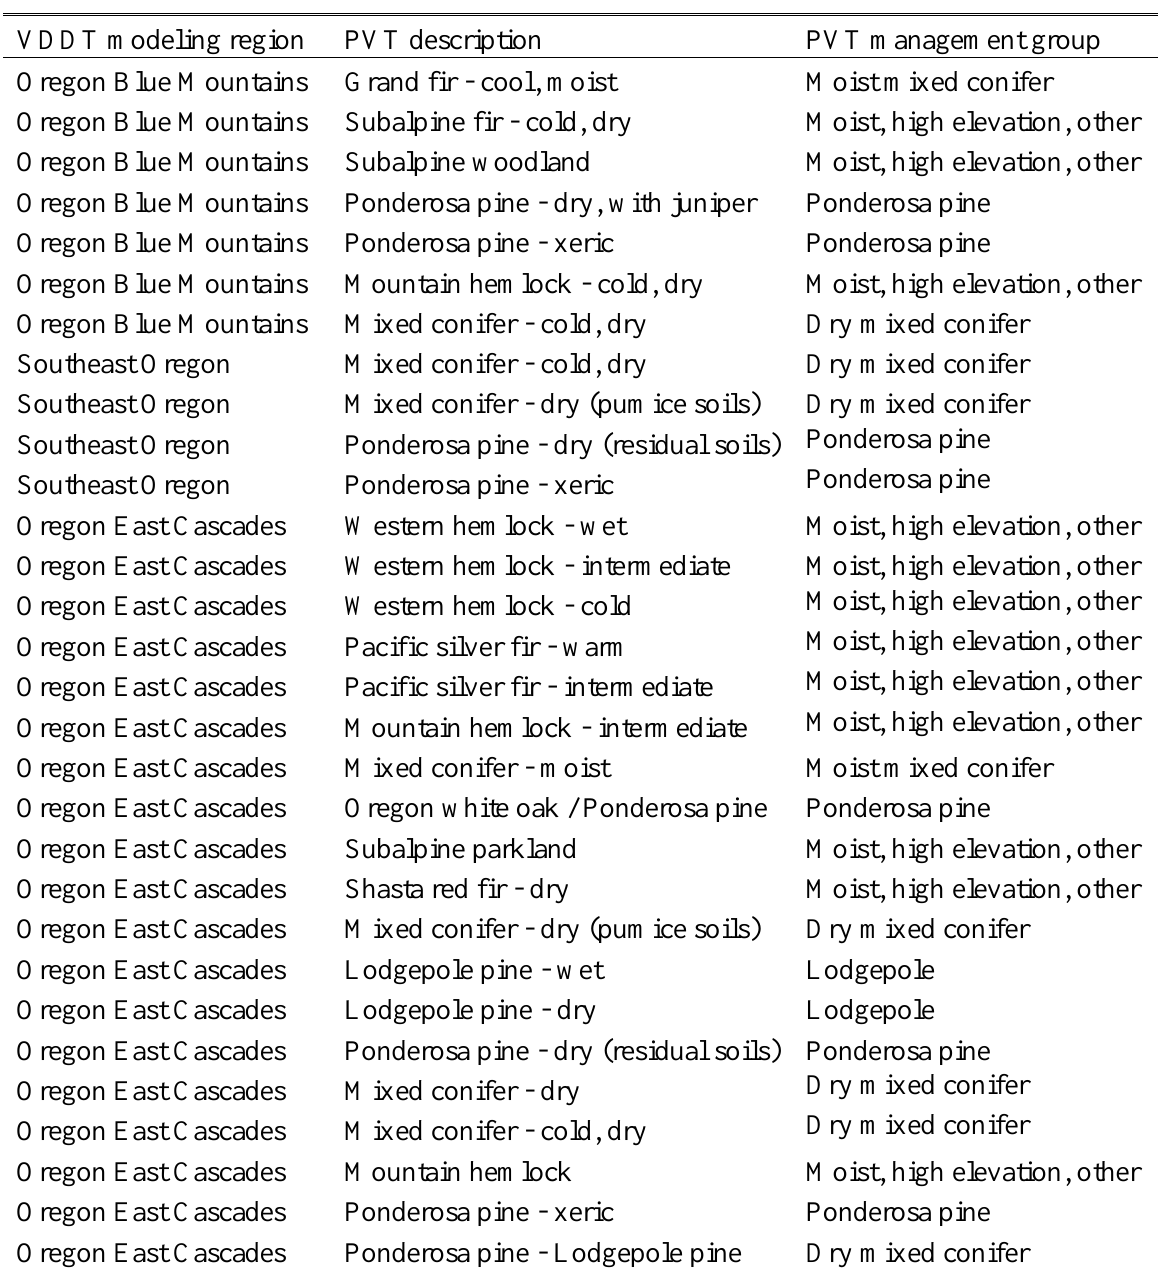
Table A1.1. Potential vegetation type (PVT) descriptions and management group by each of the Vegetation Dynamics Development Tool (VDDT) modeling regions in the study